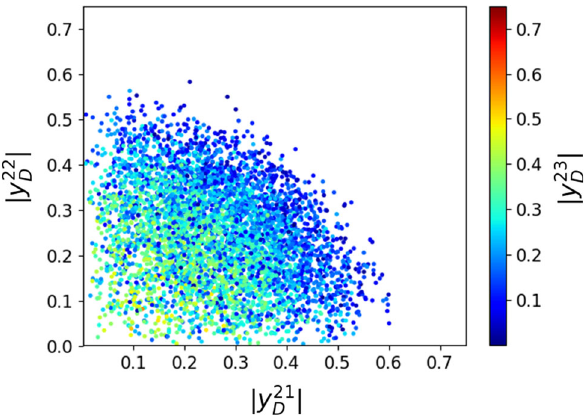
| , | y 22 | and | y 23 D D